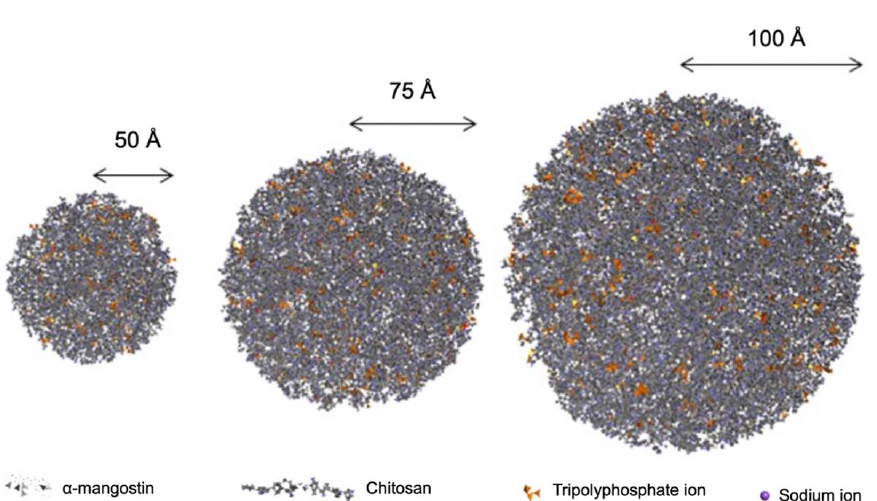
Figure 1. Combined particles of α-mangostin, sodium tripolyphosphate, and chitosan.